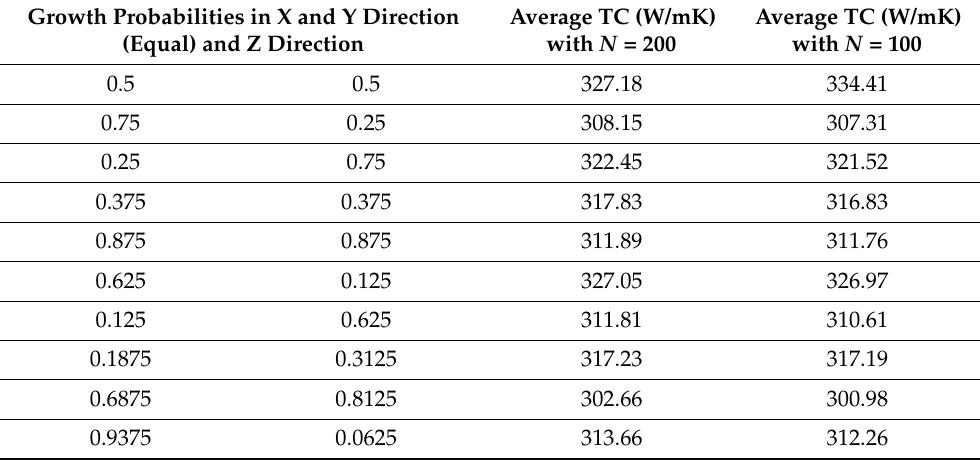
Table 2. Average TC (among three diagonal components of TC tensor) compared between 100- voxel-per-dimension RVEs and their 200-voxel-per-dimension counterparts generated as described in Section